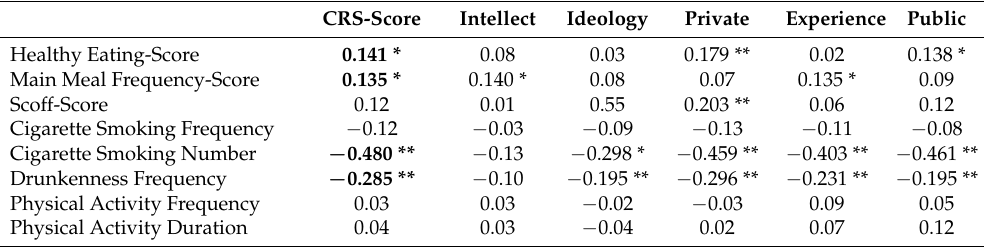
Table 3. Spearman Correlation Coefficients for health behaviours and domains of religiosity.